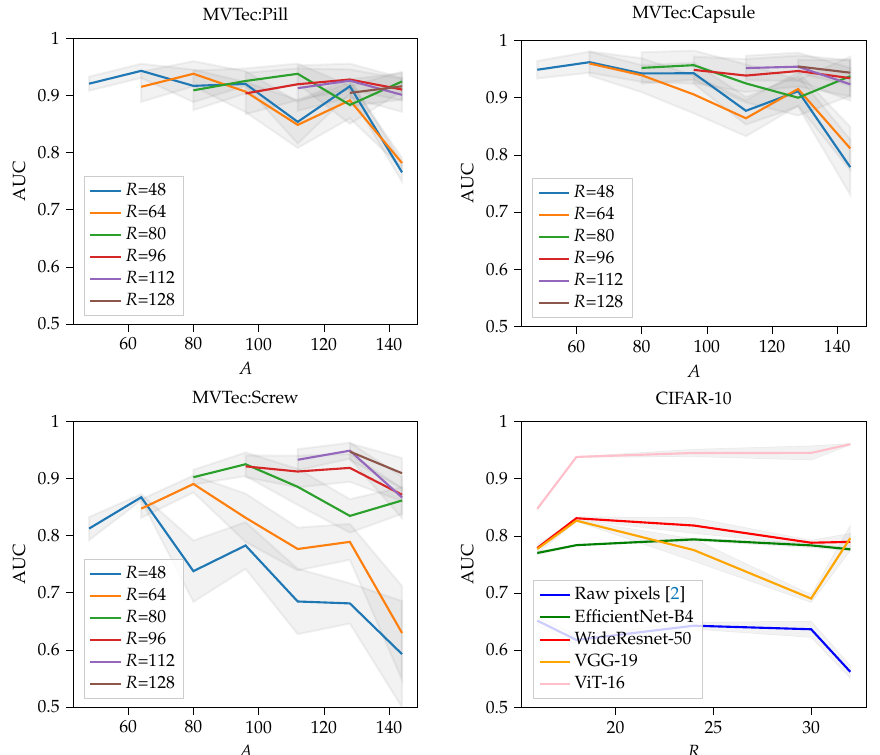
Figure 6. Varying the patch size R and the averaging region A impacts the detection rate significantly. Tests were conducted using the critical classes pill, capsule and screw classes from the MVTec dataset, and the entire CIFAR-10 dataset. The MVTec tests used the EfficientNet-B4 architecture. For CIFAR-10 we tested several popular